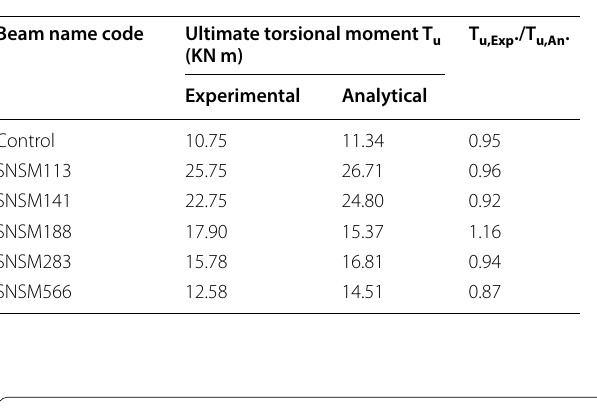
Table 7 Comparison of the experimental and analytical ultimate torsional moments.